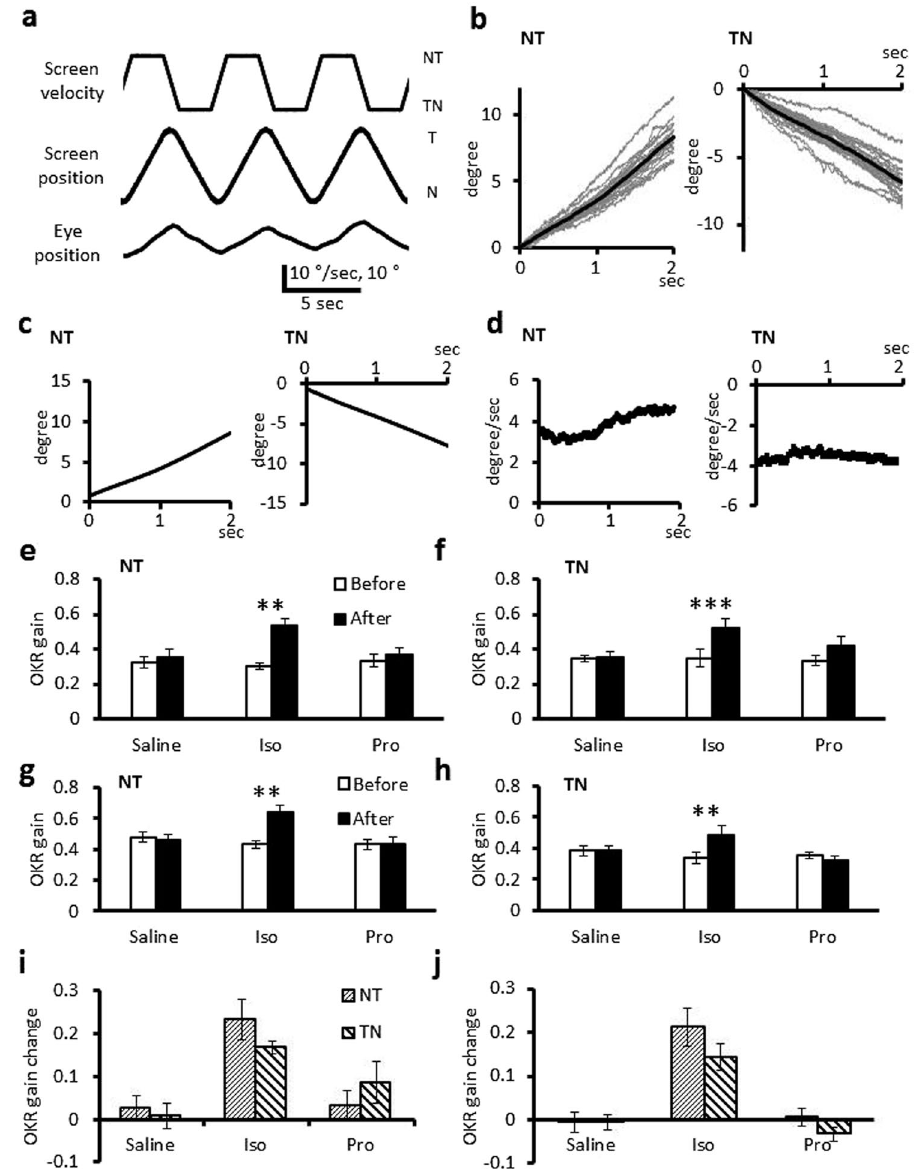
Figure 3. NT and TN eye movements during constant-velocity optokinetic stimulation. ( a ) The command velocity signal for the screen movement, screen position and a representative corresponding eye position. ( b ) Eye position traces during constant-velocity optokinetic stimulation in both NT and TN directions recorded from a mouse before administration of a drug. Gray lines indicate each data and black lines indicate averaged traces from a mouse. ( c,d ) Mean eye position ( c ) and velocity ( d ) traces obtained from 18 mice. Moving average for 0.1 sec was applied for velocity traces. ( e–h ) Effects of administration of isoproterenol, propranolol or saline on the eye velocity during the former ( e,f ) or the latter ( g,h ) 1 sec of 2 sec constant-velocity optokinetic stimulation in NT ( e,g ) or TN ( f,h ) direction. ( i,j ) Effects of administration of isoproterenol, propranolol or saline on the eye velocity changes during the former ( i ) or latter ( j ) 1 sec of 2 sec constant-velocity optokinetic stimulation. Error bars indicate SEM. ** p < 0.01, *** p < 0.001, paired Student’s